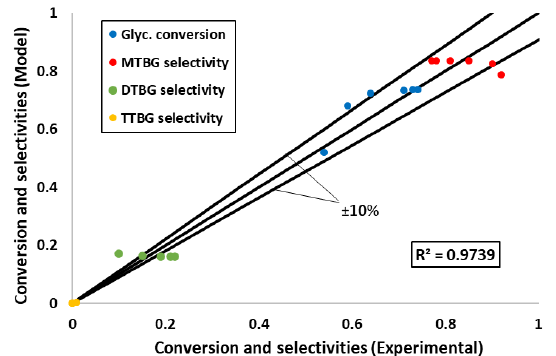
Figure 6. Parity graph of the experimental data and theoretical data (model) of glycerol conversion and product selectivities.